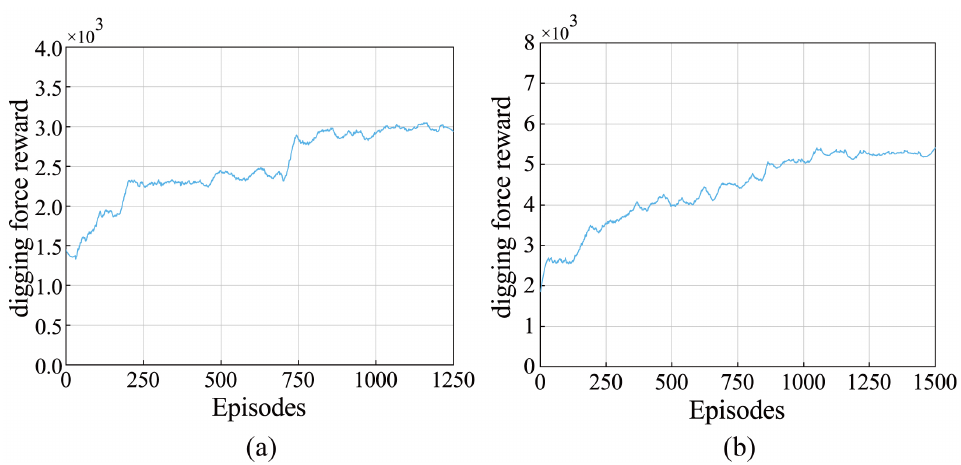
Figure 13. Digging force reward of agent on different prediction models. ( a ) Medium coarse gravel. ( b ) Small coarse gravel. Table 2. The comparison of fuel